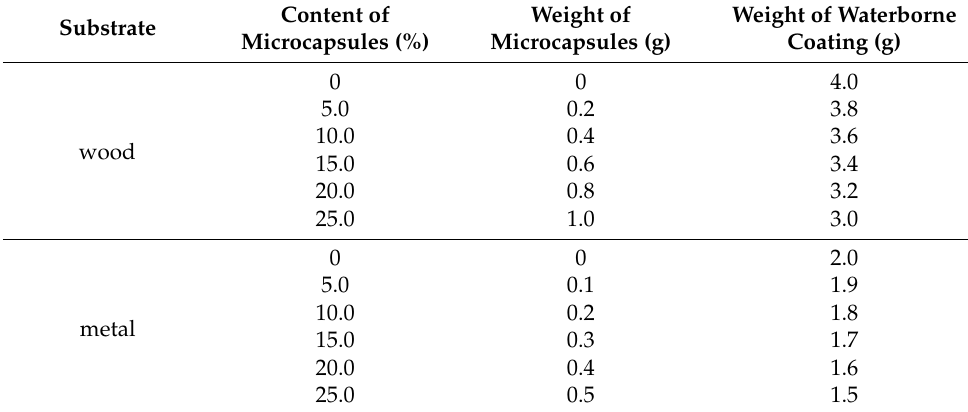
Table 4. Experimental material list.